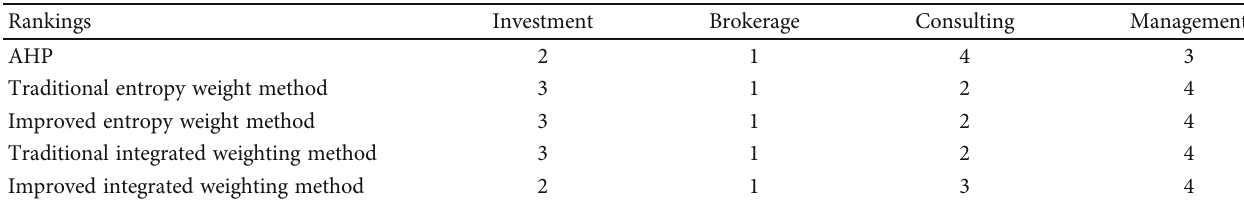
Table 7: Rankings of performance evaluation results of securities industry by di ff erent